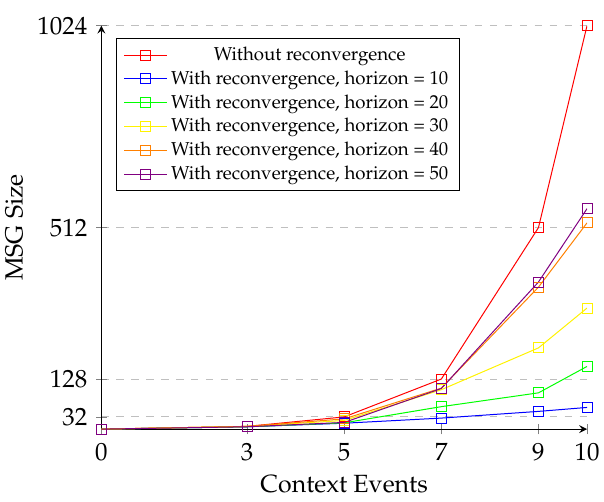
Figure 10. MSG with reconvergence for 10